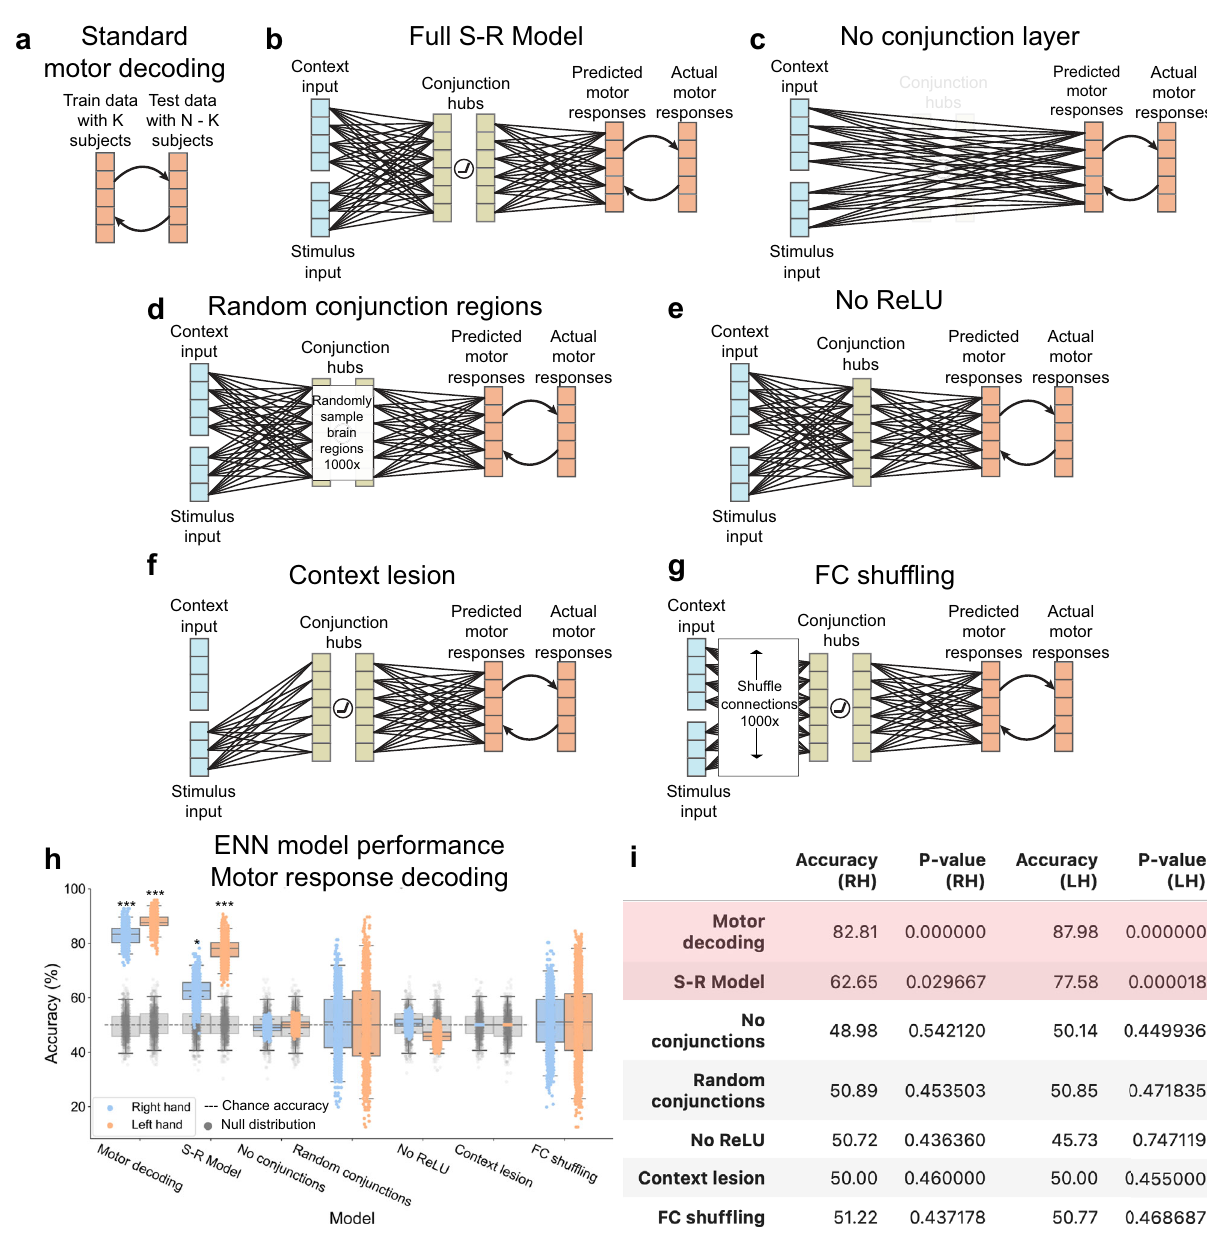
Fig. 7 Systematic alteration of ENN model architecture veri fi es validity of “ full S-R model ” results. a We fi rst benchmarked the motor response decoding accuracy for each hand separately using a standard cross-validation scheme on motor activation patterns for each hand (tested across subjects). This standard motor decoding was done independently of modeling sensorimotor transformations. b The full stimulus-response model, taking stimulus